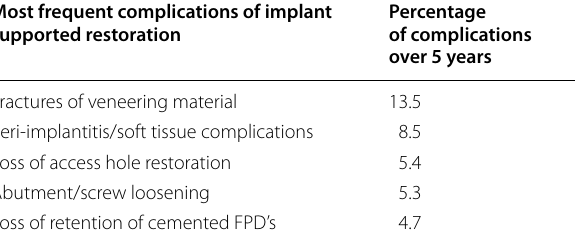
Table 3 Frequent complications in all implant supported restorations over the 5-year observation period (Sadid- Zadeh et al.